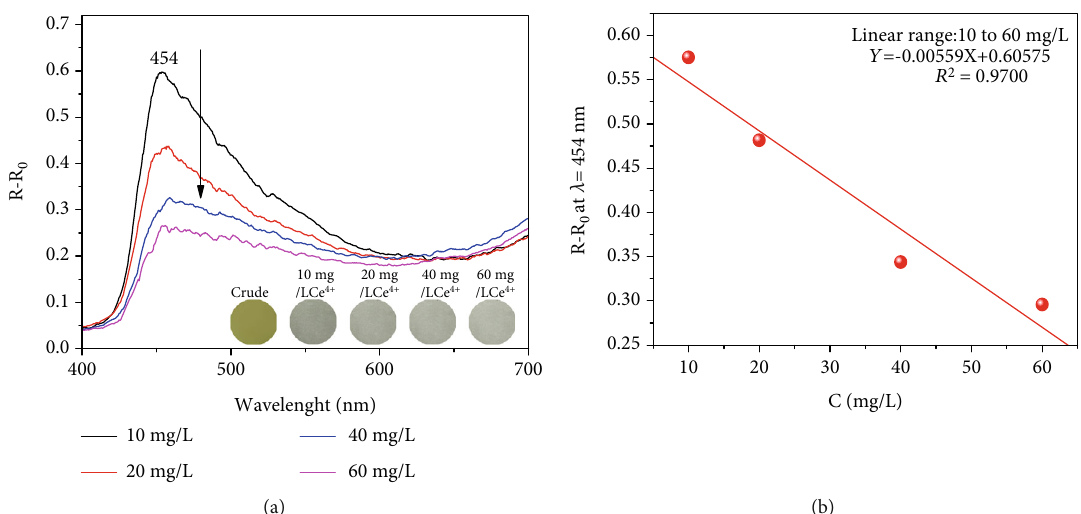
Figure 2: (a) The UV/Vis di ff use re fl ection spectroscopy of UA adsorbing Ce 4+ with di ff erent concentrations. (b) The linear relationship spectrum .The experiments were parallel performed in fi ve times. The error bars are shown with absolute values of standard deviation (SD) lower than 3%).